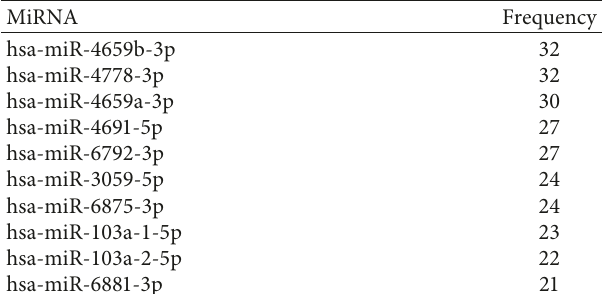
Figure 3: The functional terms and pathways enriched for the hosting genes of the differentially expressed circular RNAs (circRNAs) (top 5 listed). BP, biological process; CC, cellular component; MF, molecular function; and KEGG, Kyoto encyclopedia of genes and genomes. The black trend line represents -log10 ( p value). Table 4: The top 10 miRNAs targeting more circular RNAs